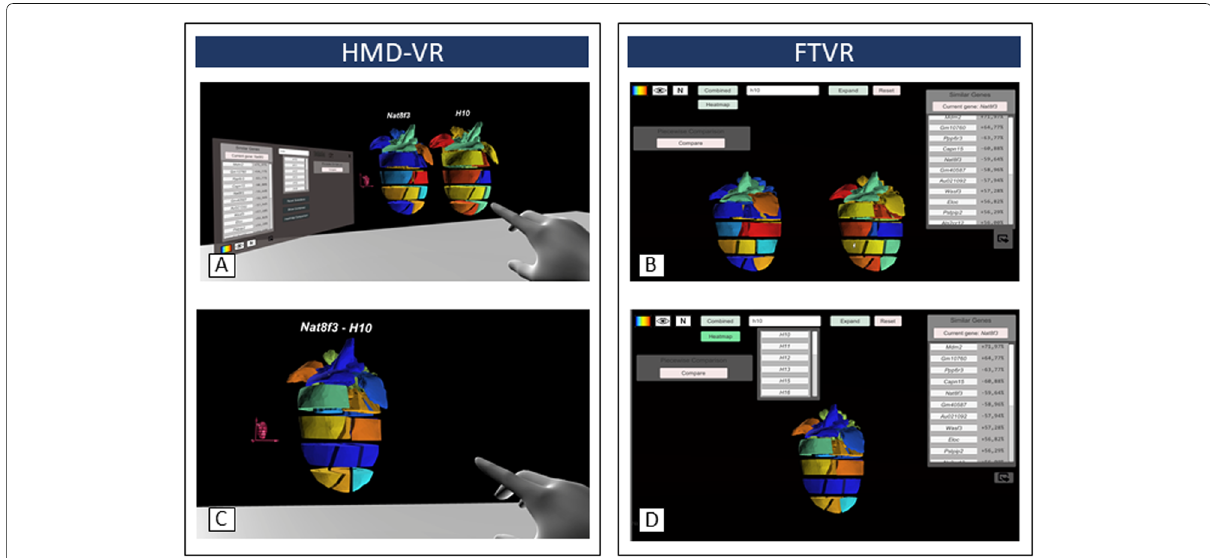
Fig. 6 Comparison of both VR-Cardiomics prototypes for HMD-VR (left) and FTVR (right). Visual side-by-side comparison of two different gene expression patterns for A) HMD-VR and B) FTVR. Heatmapcomparison in one model based on the differences of the gene expression values for C) HMD-VR and D)